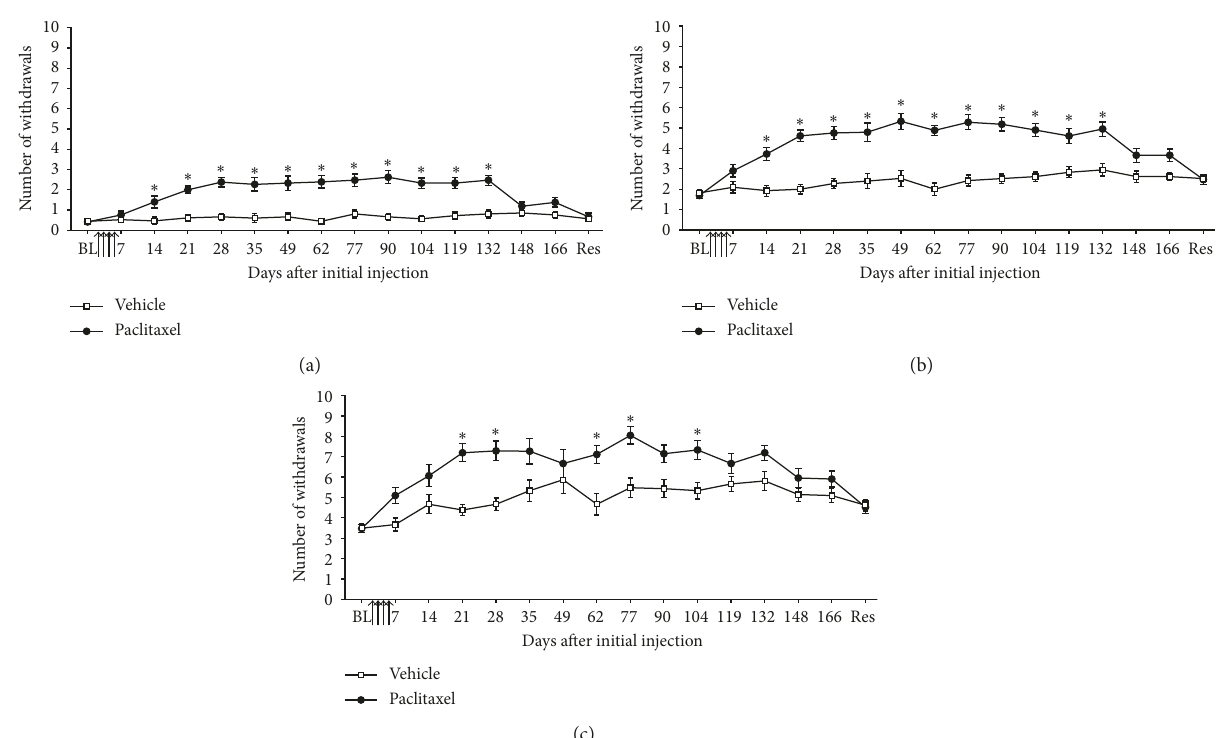
Figure 2: Time course of paclitaxel-induced mechanical hypersensitivity. Graphs show the mean to (a) von Frey 4g, (b) von Frey 8g, and (c) von Frey 15g, respectively. Arrows indicate four injections of 2mg/kg paclitaxel or equivalent volume of vehicle on days 0, 2, 4, and 6. BL which occurred between days 174 and 219.